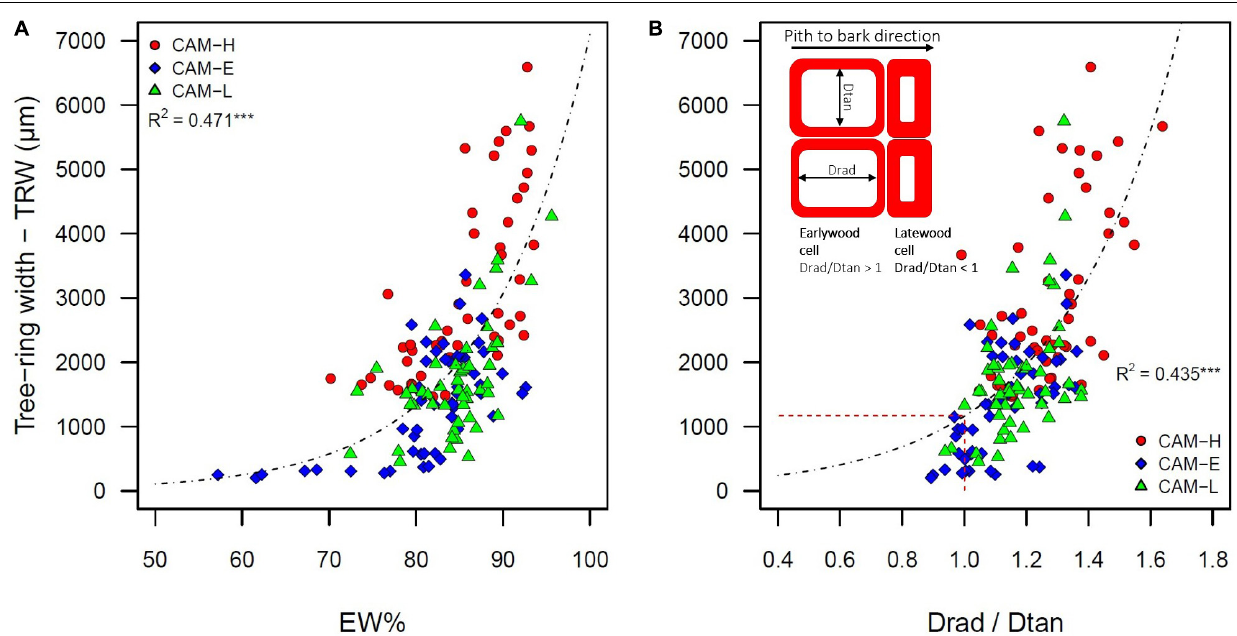
FIGURE 2 | (A) Tree-ring width (TRW) of the five outermost tree rings as a function of earlywood percentage (EW%). (B) TRW as a function of the ratio between radial diameter (Drad) and tangential diameter (Dtan) of the tracheid lumen. Values of Drad/Dtan ratio > 1 indicate that the shape of the tracheid is more EW-like. The inset figure represents a graphical sketch of earlywood and latewood tracheids as seen in a cross-section, describing the radial and tangential diameter, and their ratio. The dashed line represents the Drad/Dtan ratio equal to one. The three symbols (circle, diamond, and triangle) correspond to trees from CAM-H (red), CAM-E (blue), and CAM-L (green) plots. Both relationships were best described by an exponential function (*** P < 0.001).